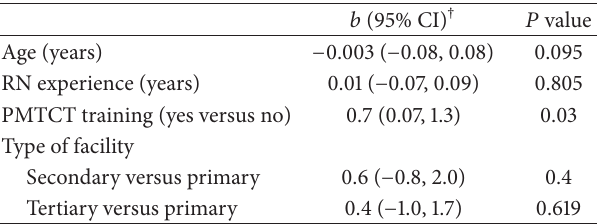
Table 5: Association between PMTCT training and PMTCT care practice using a linear mixed